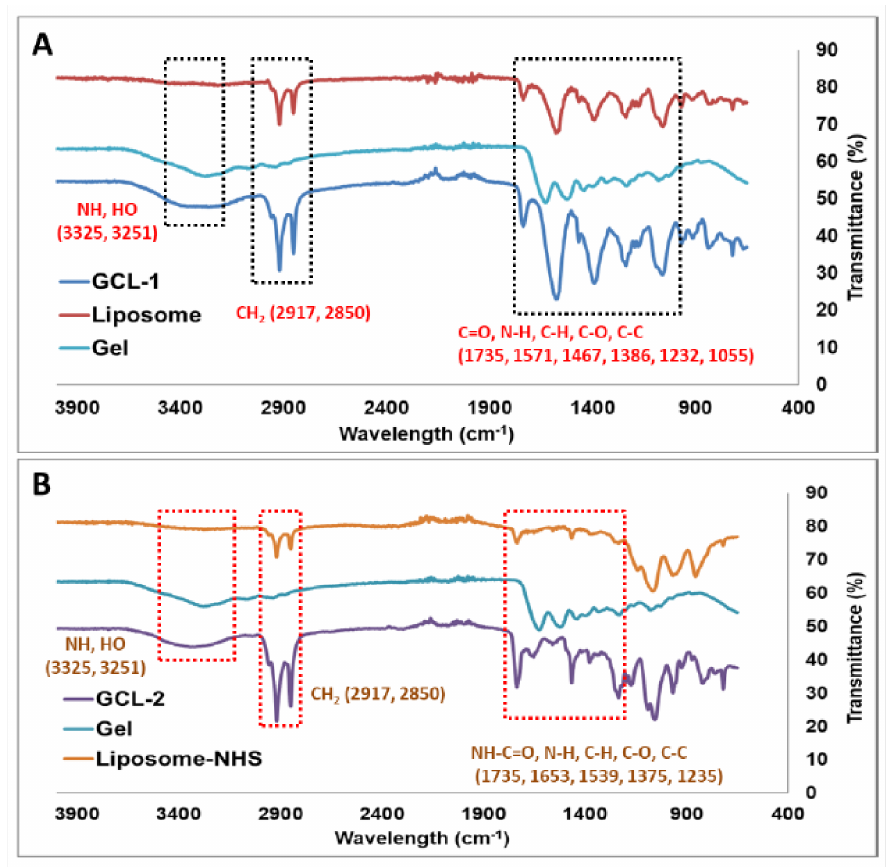
Figure 4. Graph of Fourier-transform infrared spectroscopy data comparing gelatin-coated liposome-